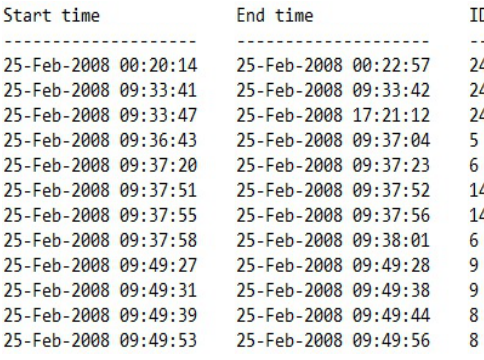
Figure 2. A part of the Kasteren House A dataset with Objects/Sensors ID represented as: 24 = Hall-Bedroom Door ; 5 = Hall-Toilet Door ; 6 = Hall-Bathroom Door ; 14 = ToiletFlush ; 9 = Plates Cupboard ; and 8 = Fridge